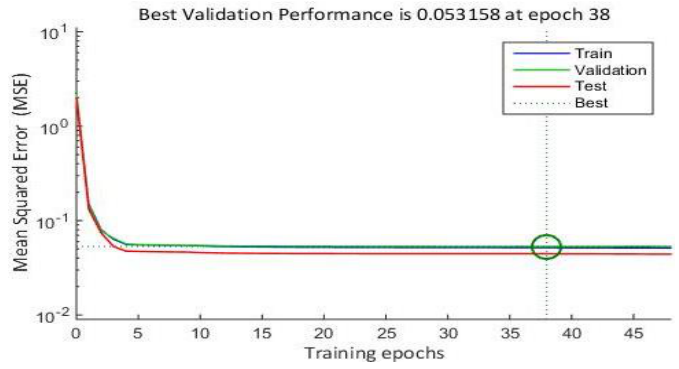
Figure 11. Convergence during training of a typical NN in NNE2D.